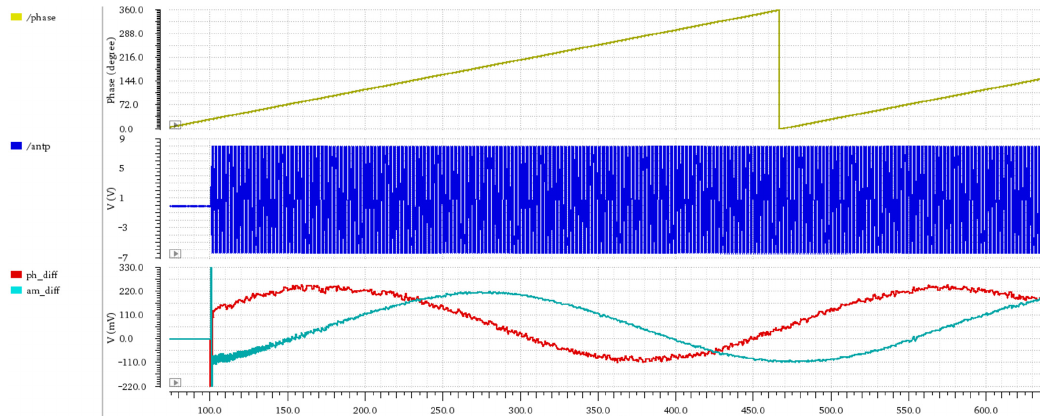
Figure 12. Simulation results for the phase and amplitude measurement system. In top subplot, the phase between the reader and the tag is shown, in middle subplot the voltage on the tag antenna is shown. In the bottom subplot, the phase measurement result (ph_diff) and amplitude measurement results (am_diff) are shown. Note the large difference between the antenna voltage before and after the transmission start at 100 us.